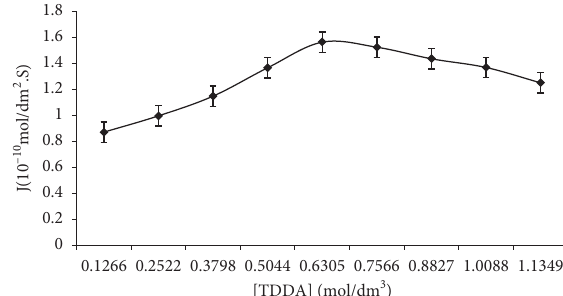
Figure 2: Effect of carrier concentration on transport of As (III).